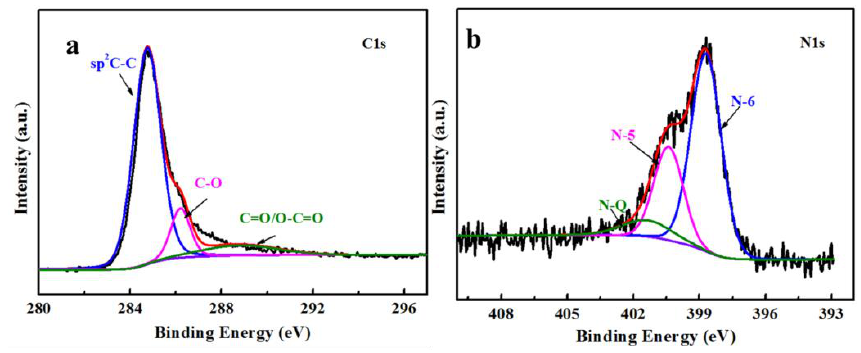
Figure 3. ( a ) C 1s spectra and ( b ) N 1s spectra of the MNPC.